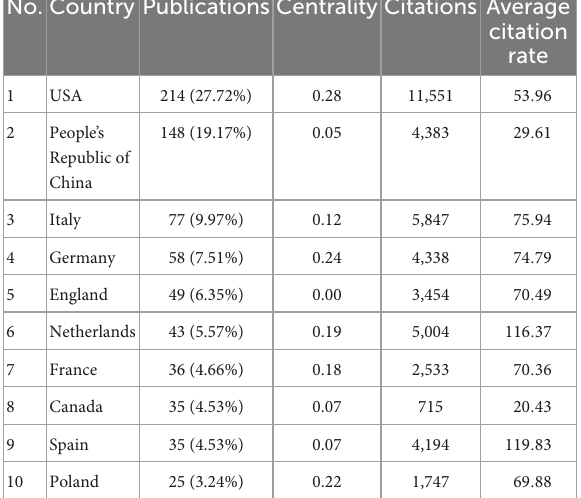
TABLE 2 The top 10 countries that contributed publications on exosomes in